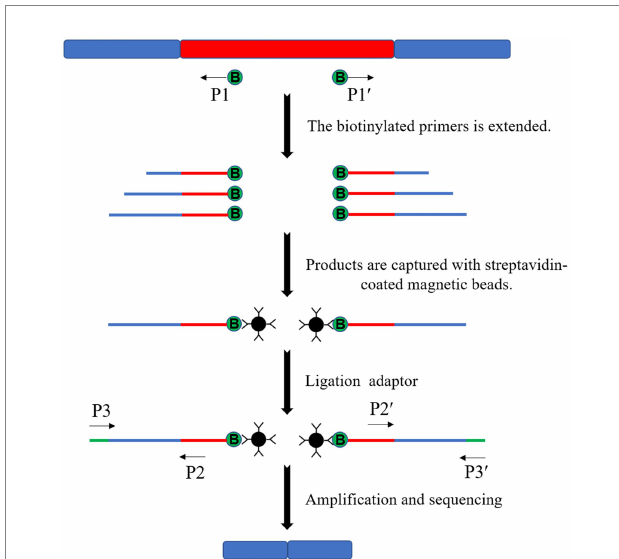
FIGURE 7 Schematic diagram of the LAM-PCR principle. Multiple single-stranded DNAs of varying lengths were amplified by the biotinylated primers. Then, multiple single-stranded DNAs are captured by streptavidin- coated magnetic beads to ligate the splice sequences and complete amplification and